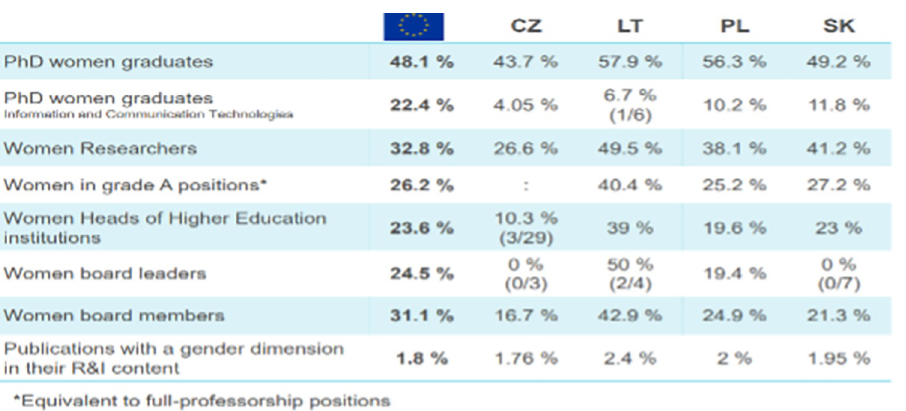
Fig 2. Share of women in the science and research sector in selected EU countries (2021). Source: She Figures 2021, after: A. Pe´pin, Webinar: "Gender equality in European Research, Innovation and Higher Education. How to enhance scientific excellence through Gender Equality Plans?", 10.03.2022.